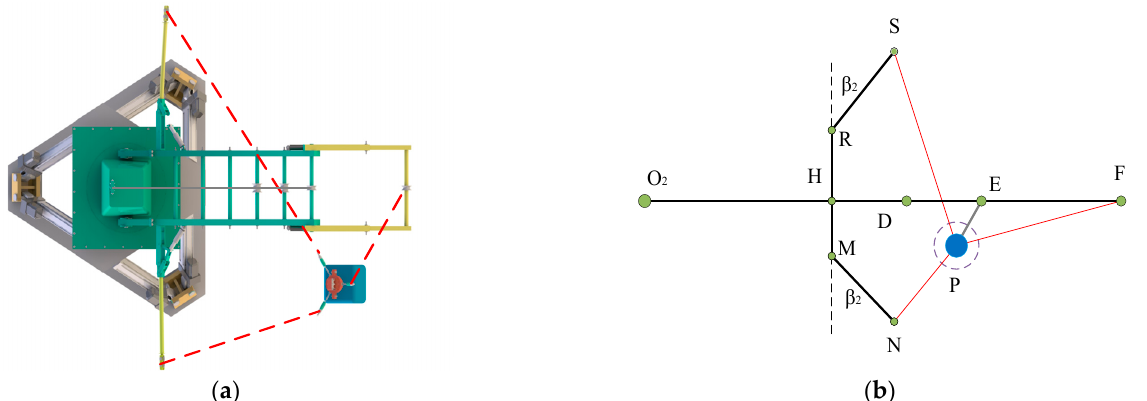
Figure 4. Top view of mechanical structure: ( a ) top view of three-dimensional mechanical structure; ( b ) simplified top view of two-dimensional mechanical structure.